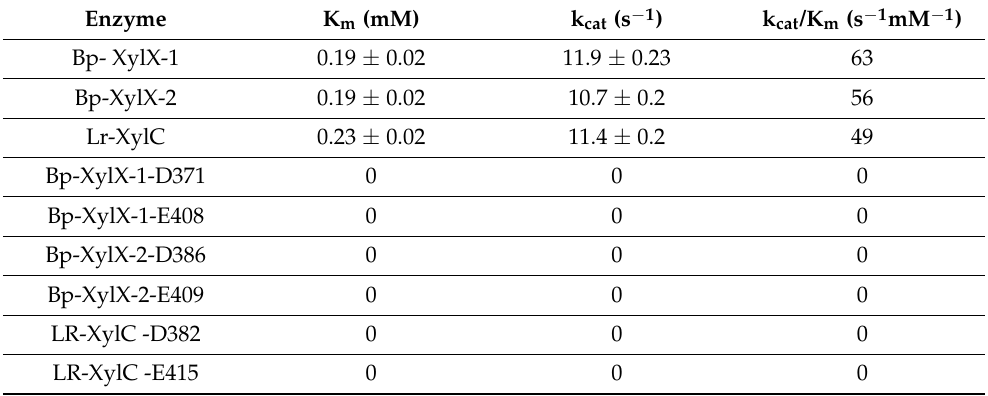
Table 1. Kinetic analysis of recombinant β -D-xylosidases from L. reuteri and B. producta strains using pNP-Xyl as substrate, determined in 50 mM sodium phosphate buffer (pH 5.7) at 45 ◦ C. Enzyme K m (mM) k cat (s − 1 )